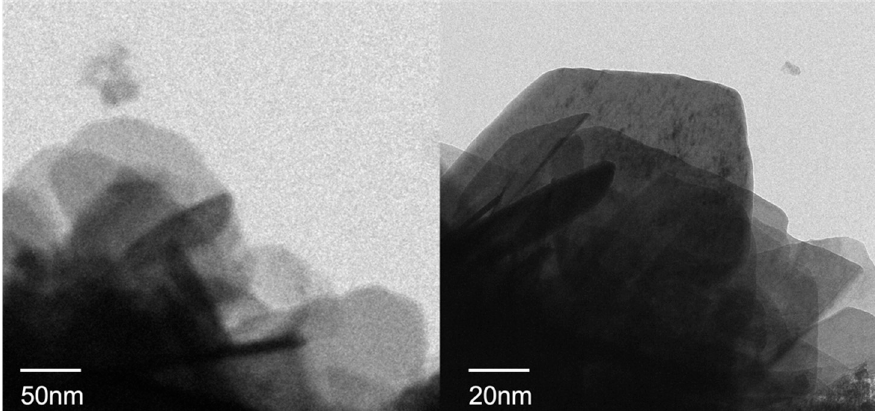
Figure 13. TEM image of M6-Fe.